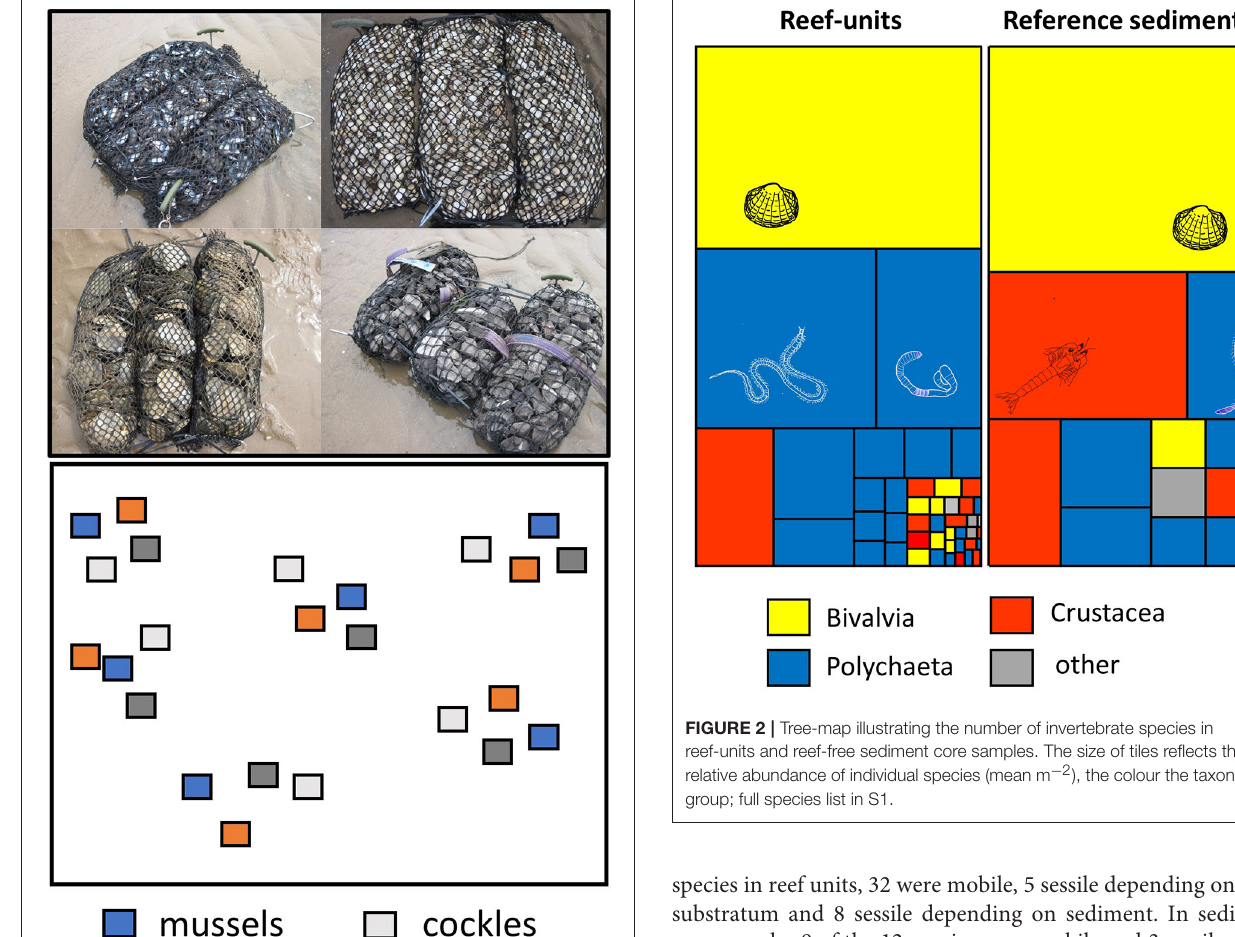
species in reef units, 32 were mobile, 5 sessile depending on